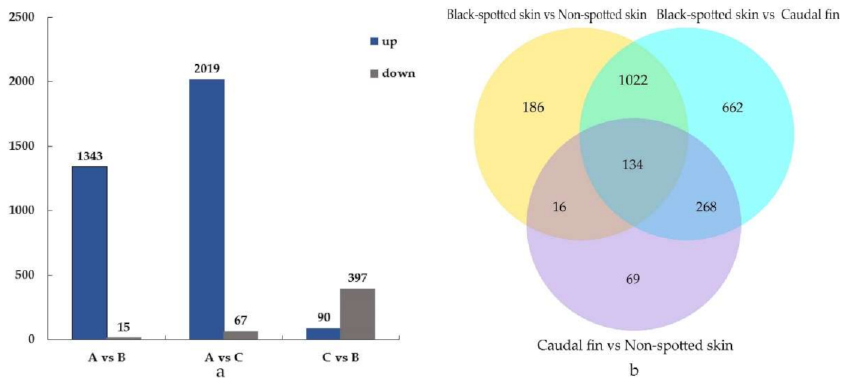
Figure 2. ( a ) Comparison of the number of differentially expressed genes (DEGs) in three different tissues of S. argus . The horizontal axis represents the samples on the control of the situation, and the vertical axis measures the difference of gene numbers. There are two expression levels. The blue color stands for the upregulated expression, and the gray color represents the downregulated expression. ( b ) DEG number and Venn diagram of the overlap of the different groups. A (black-spotted skin), B (non-spotted skin) and C (caudal fin).